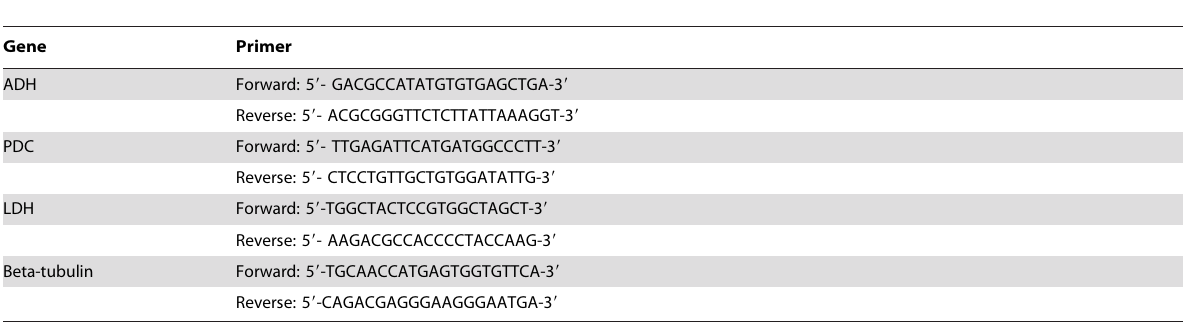
Table 4. Pairs of gene-specific primers used in qPCR analysis.